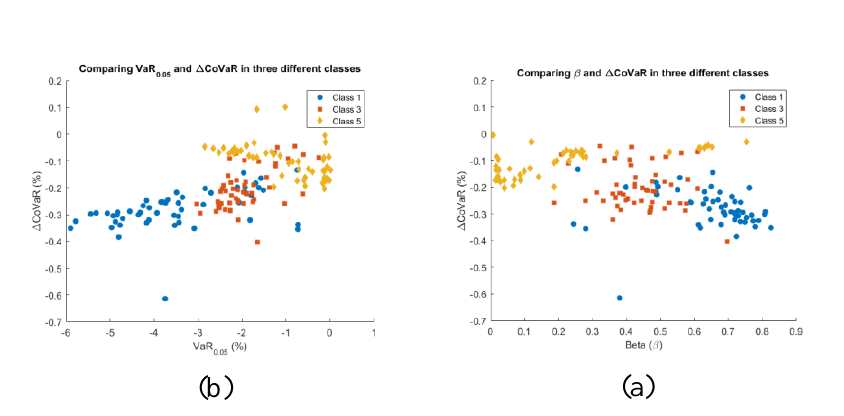
Figure 6. The Scatter Plots of a) Beta Coefficient and ΔCoVaR and b) VaR and ΔCoVaR for